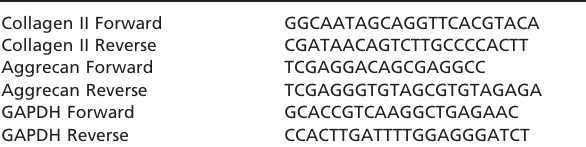
Table 1 - The primer sequences used in qRT-PCR. Primer sequences for all genes were designed using the ABI Primer Express program (Applied Biosystems, Foster City, CA, USA).